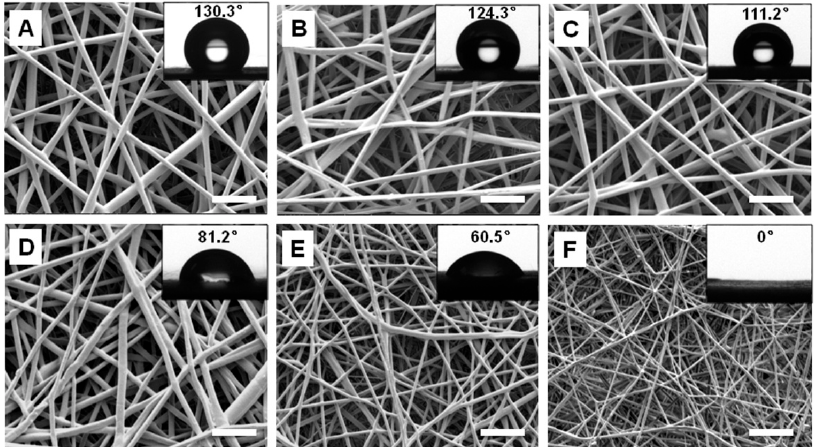
Figure 1. SEM and water contact angle measurements of electrospun poly( L -lactide)/poly(ethylene glycol) (PLLA/PEG) scaffolds with PEG fractions of 0% ( A ); 10% ( B ); 20% ( C ); 30% ( D ); 40% ( E ); and 50% ( F ), respectively. Both the fiber diameter and water contact angle decreased with the increase of PEG content. Scale bars, 10 μ m.